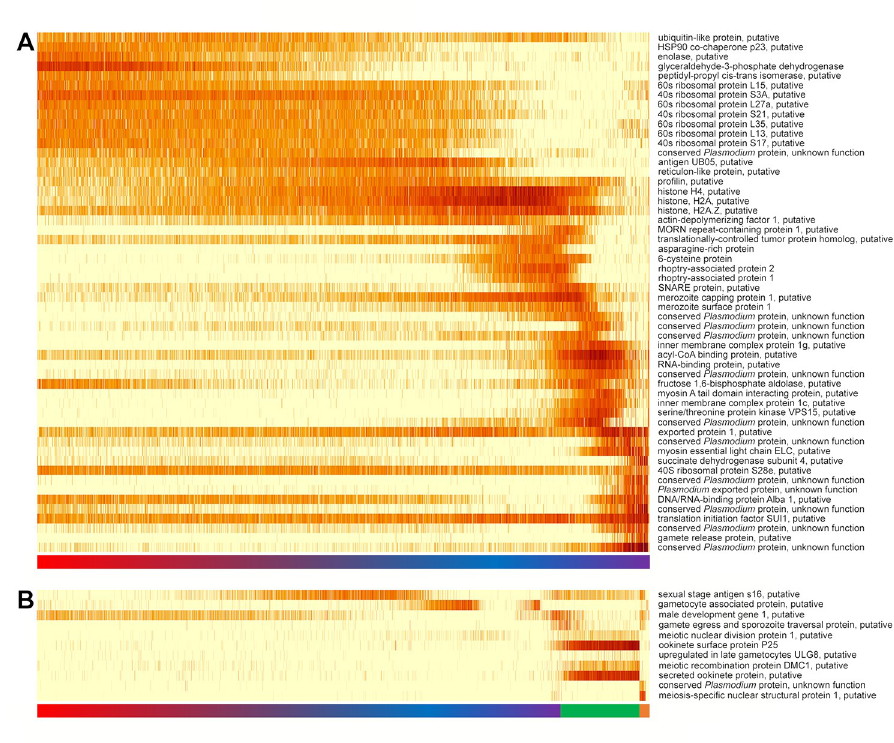
Fig 2. Heatmaps showing variations in gene expression among blood-stage P . vivax parasites. (A) Variations in the expression levels of the genes most expressed at different times of the P . vivax asexual development. (B) Variations in the expression levels of genes previously associated with gametocytes or gametes. Each row represents a different gene, and each vertical bar an individual P . vivax parasite ranked along the x-axis based on its pseudotime. The color of each bar represents the expression level of a specific transcript from nondetected (white) to highest expression (in red) in yellow-to-red scale. The color bar under the heatmaps shows the assignment of the parasites to different morphological stages (red, trophozoites; blue and purple, schizonts; green, female gametocytes; orange, male gametocytes). Underlying data plotted in panels A and B are provided in S2 Data.